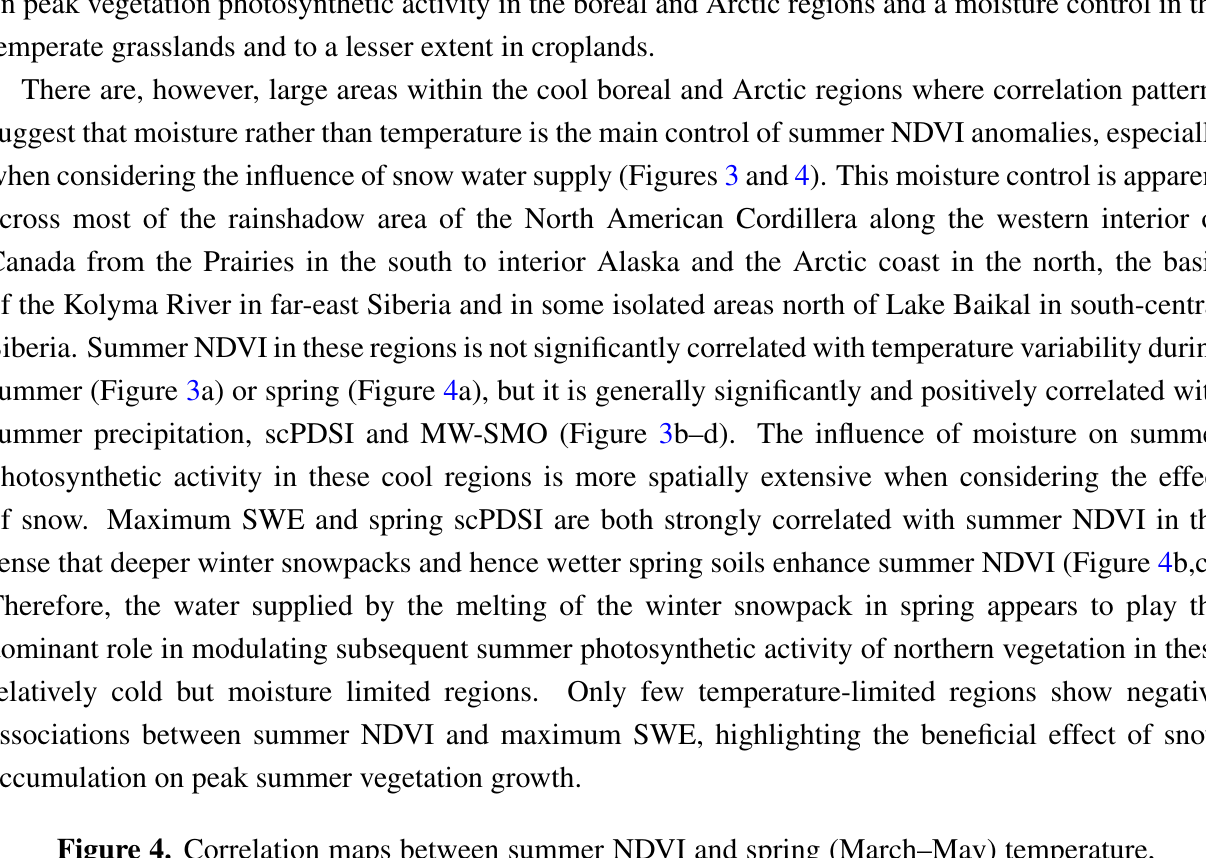
Figure 4. Correlation maps between summer NDVI and spring (March–May) temperature, snow water supply and soil moisture variability since 1982. ( a ) Spring air temperature; ( b ) Maximum Snow Water Equivalent (SWE); ( c ) Spring scPDSI. All correlations are based on linearly detrended data and the stippling indicates statistically significant ( p < 0.1)